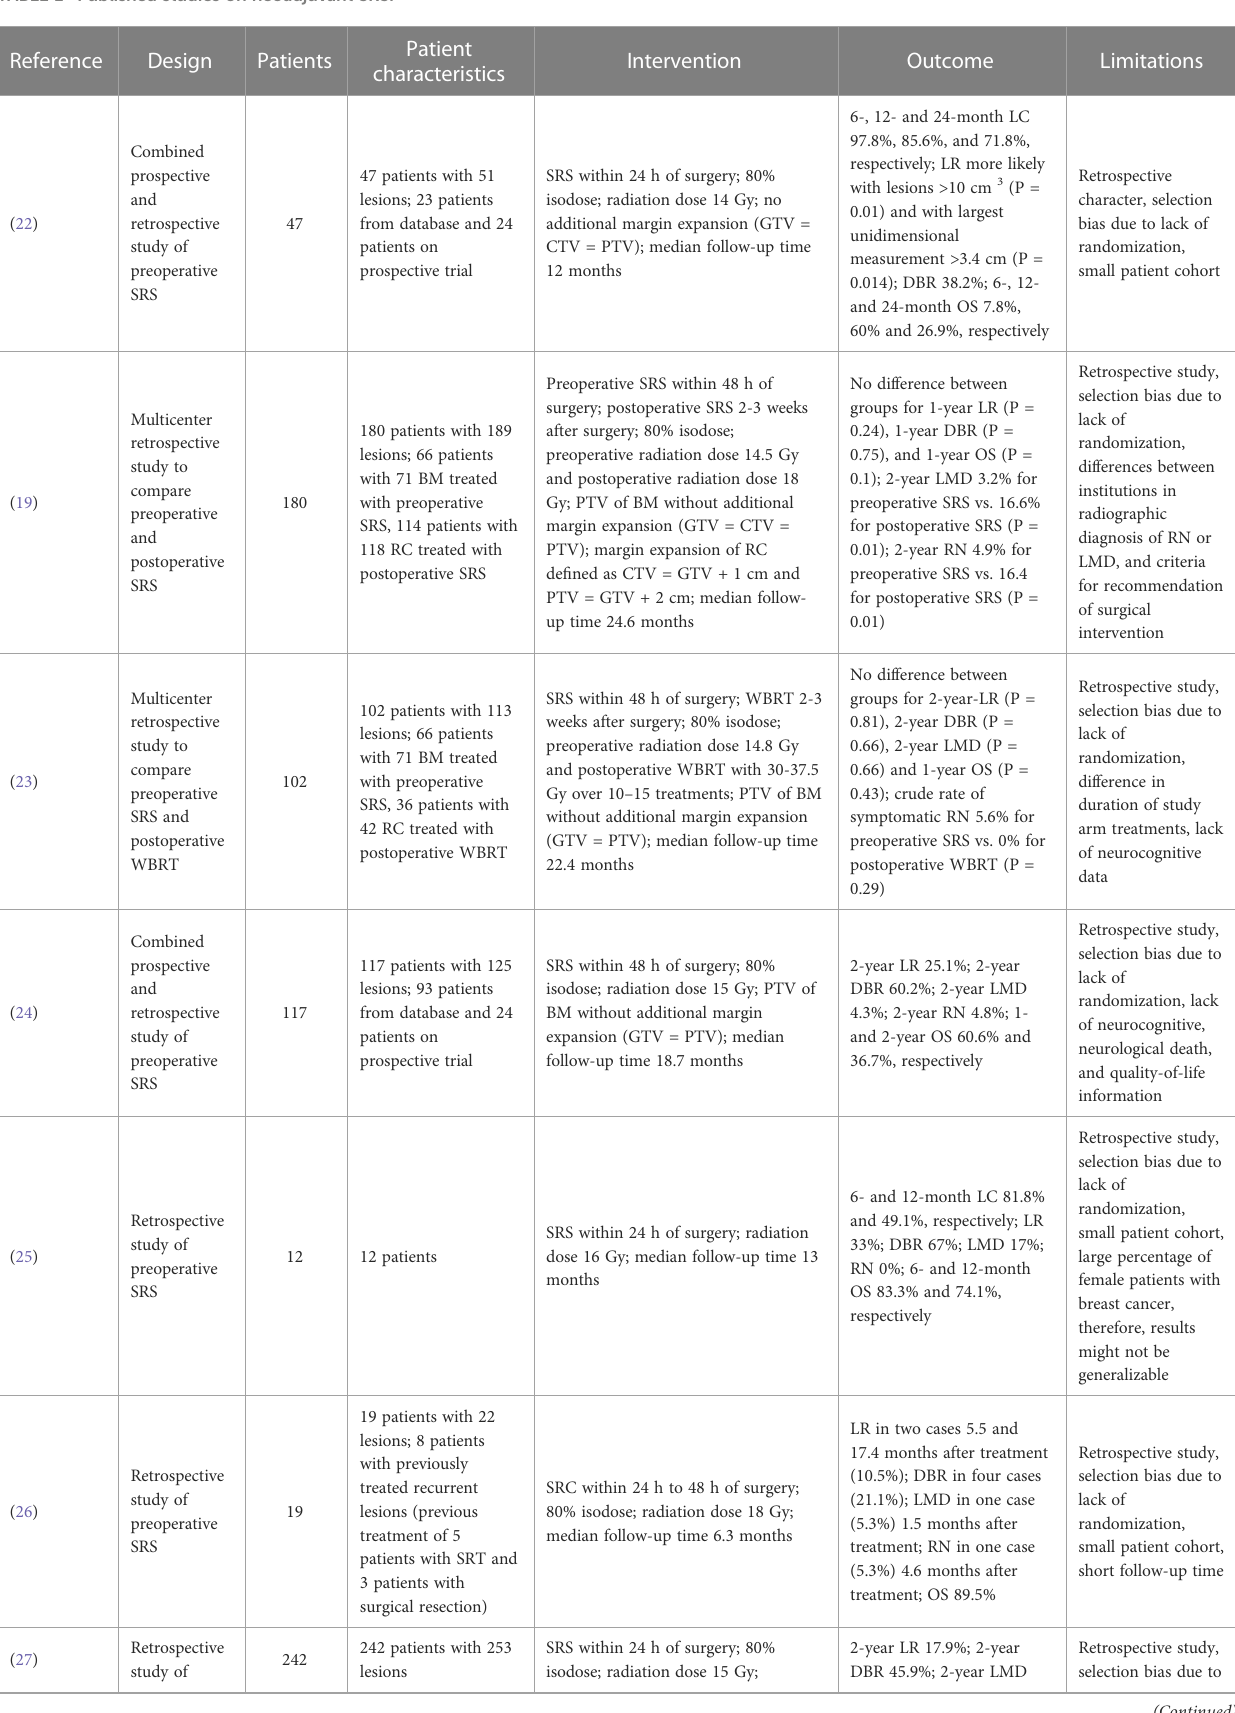
TABLE 1 Published studies on neoadjuvant